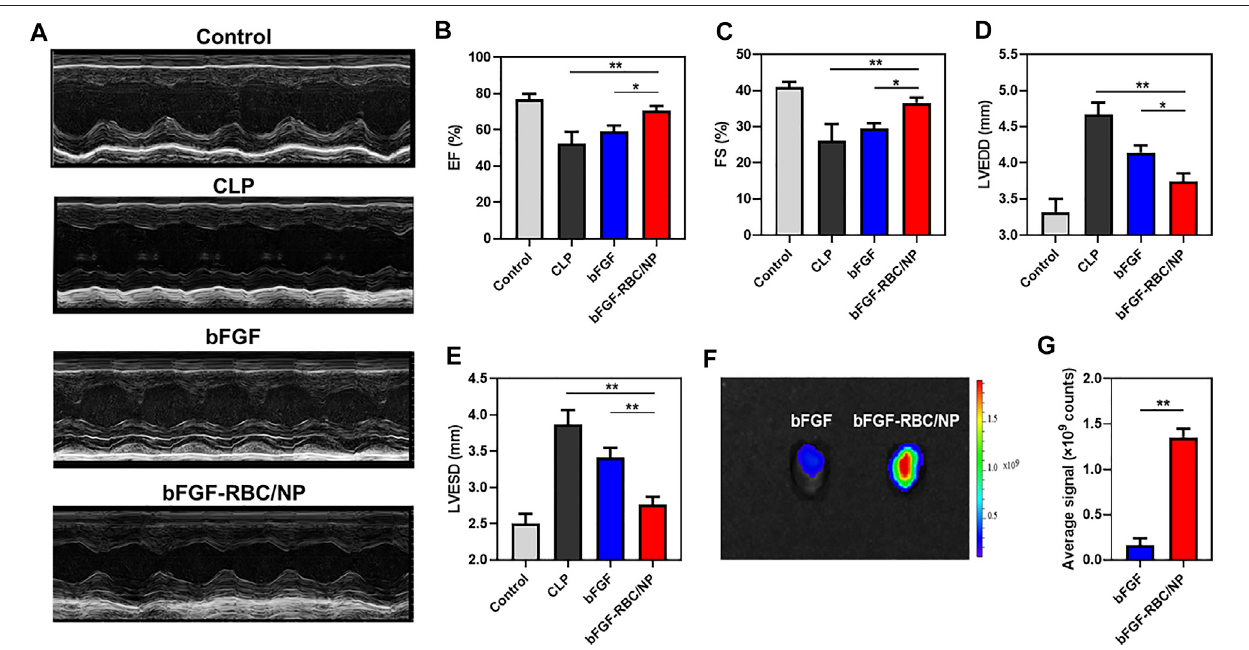
FIGURE4| AssessmentofcardiacfunctionanddistributionofbFGF-RBC/NPintheheart. (A) Representativeechocardiographicimagesofeachgroup.Thelevels of (B) left ventricular ejection fraction (EF), (C) left ventricular fractional shortening (FS), (D) left ventricular end-diastolic diameter (LVEDD), and (E) left ventricular end- systolic diameter (LVESD). (F) Fluorescent distribution of Cy5-labeled bFGF and Cy5-labeled bFGF-RBC/NP in the heart of mice 90 min after bFGF or bFGF-RBC/NP injection. (G) Quantitative analysis of the fl uorescent intensity in the heart. Data are expressed as the mean ± SD ( n = 3). * p < 0.05 and ** p < 0.01.